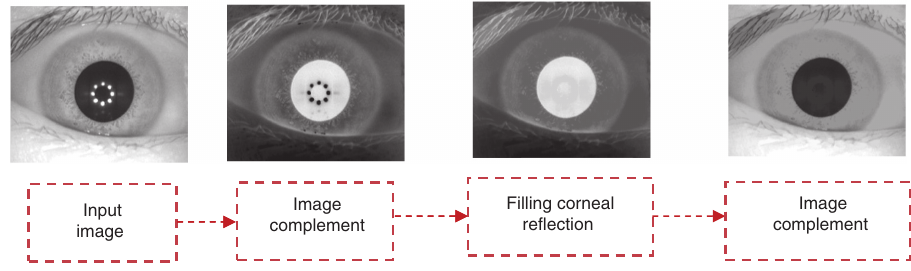
Figure 4. Reflection Removal